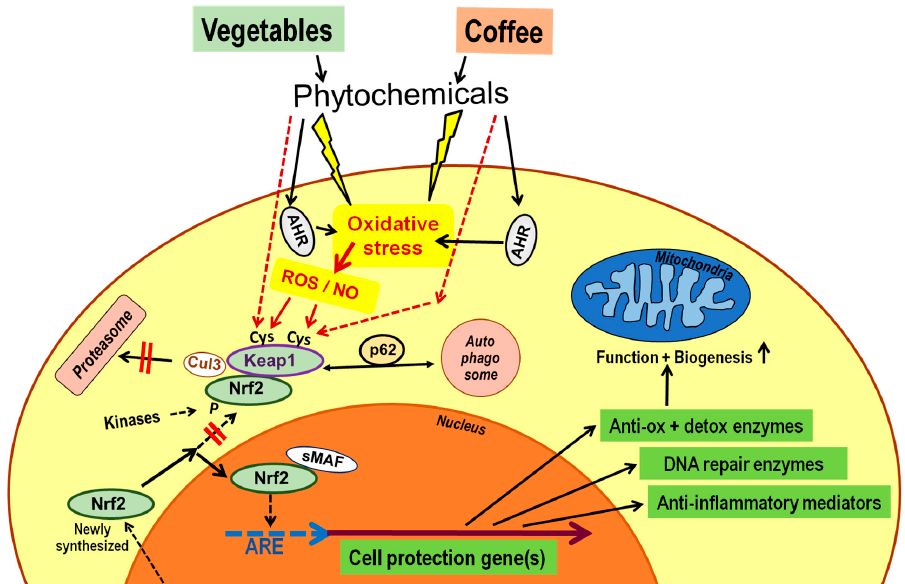
Figure 2. Phytochemicals activate the nuclear factor erythroid 2-related factor 2 (Nrf2) pathway. Exposure of cells to phenolics of vegetables or coffee leads to cell stress, including oxidative stress via mostly unknown pathways, except for some involvement of the aryl hydrocarbon receptor (AHR). Major sources of radical oxygen species (ROS) during oxidative stress are the mitochondrial respiratory chain and nicotinamide adenine dinucleotide phosphate (NADPH) oxidases of the NOX family. The nuclear factor Nrf2 is usually bound to Keap1 and the Cullin 3-based E3 ubiquitin ligase (Cul3), which is followed by transport to the proteasome for degradation. This process can be blocked by modification of one or more cysteine residues of Kelch-like ECH-associated protein 1 (Keap1) by ROS, ROS-modified fatty acids or cyclic nucleotides, by nitric oxide (NO), or by direct action of phytochemical electrophiles. The protein p62 blocks binding of Nrf2 to Keap1 and channels Keap1 to autophagic destruction. Several kinases, such as members of the Src family, can phosphorylate Nrf2 and may also interfere with routing to proteasomes. All these mechanisms prevent newly formed Nrf2 from being captured by Keap1, so that translocation to the nucleus is possible. In the nucleus, Nrf2 binds to small musculoaponeurotic fibrosarcoma (sMaf) protein, and the heterodimer interacts with the antioxidant response element (ARE) upstream of several hundred genes involved in cell defense mechanisms, resulting in enhanced transcription. The following points are not depicted in the scheme: AHR forms a complex with several other proteins including heat shock protein (hsp) 90. AHR activation by selective phytochemicals not only increases intracellular oxidative stress but also leads to translocation of the factor to the nucleus where it upregulates a set of genes involved in xenobiotic defense and immunoregulation. Some of the intranuclear Nrf2 molecules are phosphorylated. Nrf2 gene expression can be modified by affecting its transcription, such as by inhibitory microRNAs; additionally, Keap1 gene expression can also be modified. Under steady physiological conditions, the majority of newly synthesized Nrf2 is captured by the repressor protein Kelch-like ECH-associated protein 1 (Keap1) and channeled to proteasomal degradation via ubiquitylation by Cullin 3-based E3 ubiquitin ligase (Cul3). Keap1 is the main cellular sensor for stress molecules due to expression of 17 cysteine residues which are targets for modification by radical oxygen species (ROS), ROS-modified fatty acids or cyclic nucleotides, nitric oxide (NO) or other electrophiles [46]. Any modification suppresses the ability of Keap1 to transfer Nrf2 to proteasomes, which prevents Keap1 from capturing new Nrf2 molecules so that newly synthesized Nrf2 can translocate to the nucleus [47]. Phytochemicals may either directly target cysteines of Keap1, such as sulforaphane, or modify cell functions, resulting in oxidative stress and subsequent inactivation of Keap1. The interaction of different electrophiles with Keap1 leads to different patterns of modified cysteine residues, and to the activation of different patterns of